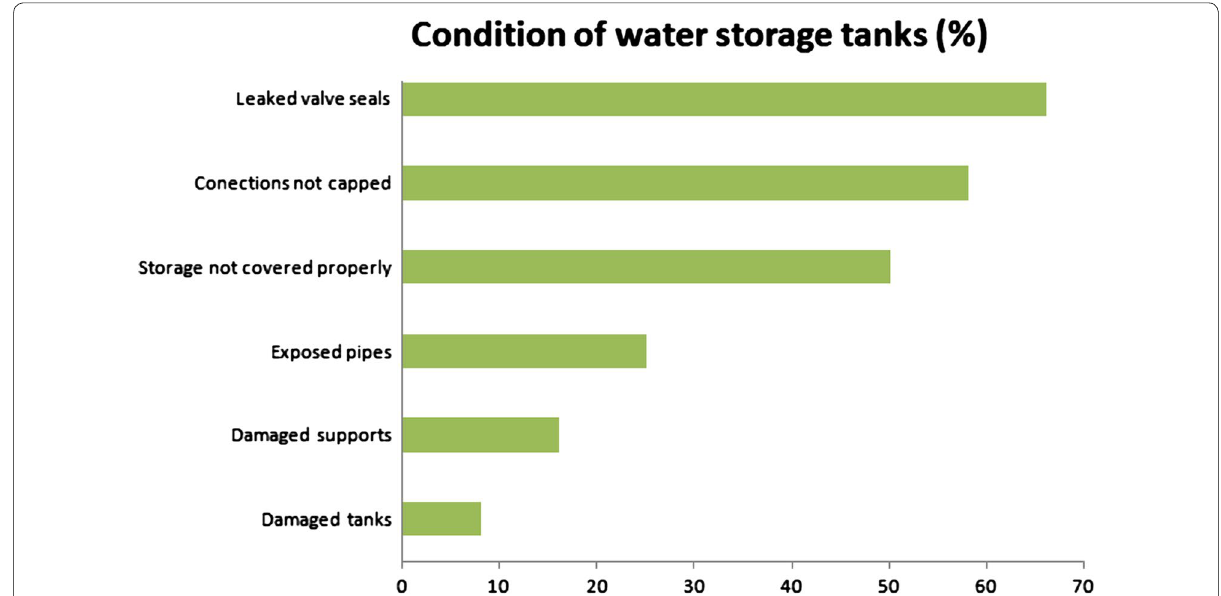
Fig. 2 Hygienic conditions of water storage